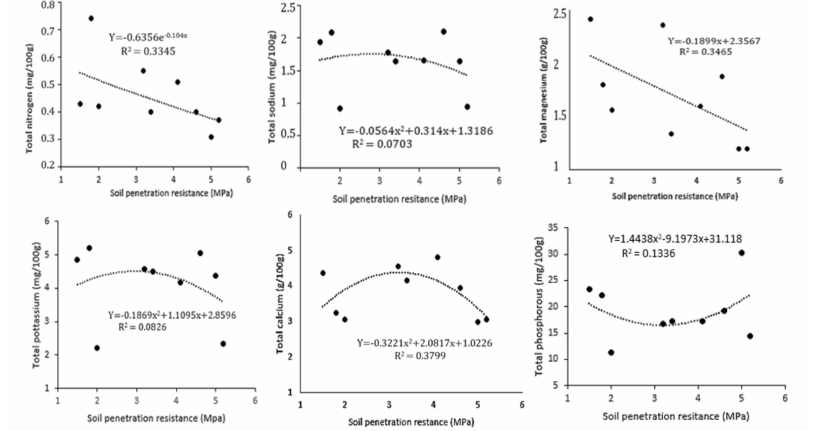
Figure 1. Effects of compaction on nutrient uptake of maize crop